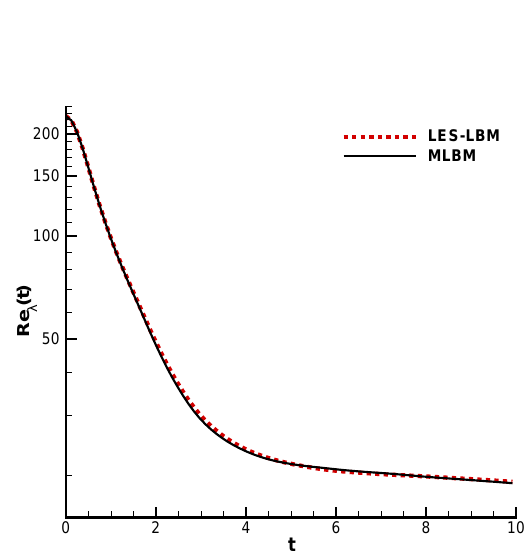
Fig. 4 Comparison of Taylor microscale for initial Re λ = 225 evolution on mesh 256 3 .